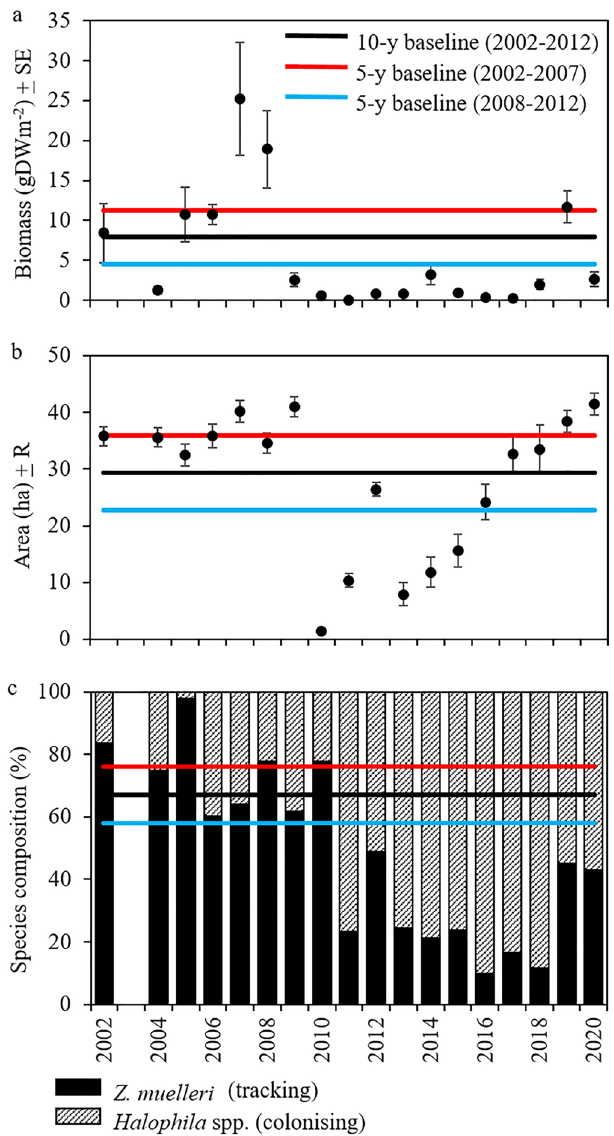
Figure 2. Comparison of baselines for ( a ) biomass (using meadow 104 as an example), ( b ) area (meadow 4), and ( c ) species composition (meadow 8) calculated using 10 years of data (black line), 5 years (2002–2007) during El Niño conditions (red line), and 5 years (2008–2012) that included several years of intense La Niña conditions (blue line). Species composition in ( c ) shows baseline for dominant (tracking) species Zostera muelleri relative to less persistent, colonising Halophila